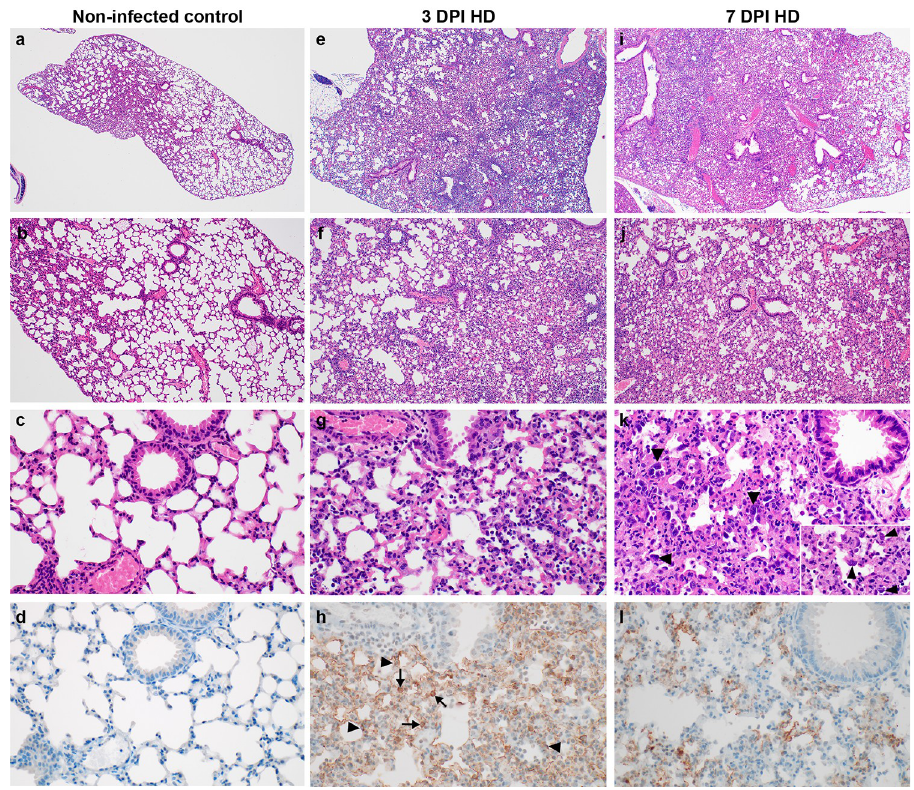
Fig 3. Pathological changes in lungs of K18-hACE mice inoculated with SARS-CoV-2 at 3 and 7 DPI. a, b, c, d. γ - irradiated SARS-CoV-2 inoculated control lungs appear normal and lack SARS-CoV-2 antigen immunoreactivity. e, f, g . Inflammation at 3 DPI, characterized by perivascular and septal infiltration by neutrophils, macrophages, lymphocytes, and edema. i, j, k. Multifocal interstitial pneumonia at 7 DPI, characterized by type II pneumocyte hyperplasia (arrowheads), alveolar and perivascular inflammation, fibrin, edema, syncytial cells (inset arrowheads) and single cell necrosis. h, l. SARS-CoV-2 antigen immunoreactivity in type I (arrowheads) and type II pneumocytes (arrows) at 3 and 7 DPI. HD: high dose (10 5 TCID 50 SARS-CoV-2). Magnification: a, e = 40 x; b, f = 100 x; c, g, h = 400 x, inset 1000 x.